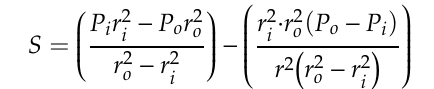
8 of 12 Figure 9. Measurements of the creep-buckling failure for Tube 3-03: ( A ) Linear horizontal axis and ( B ) logarithmic horizontal axis.